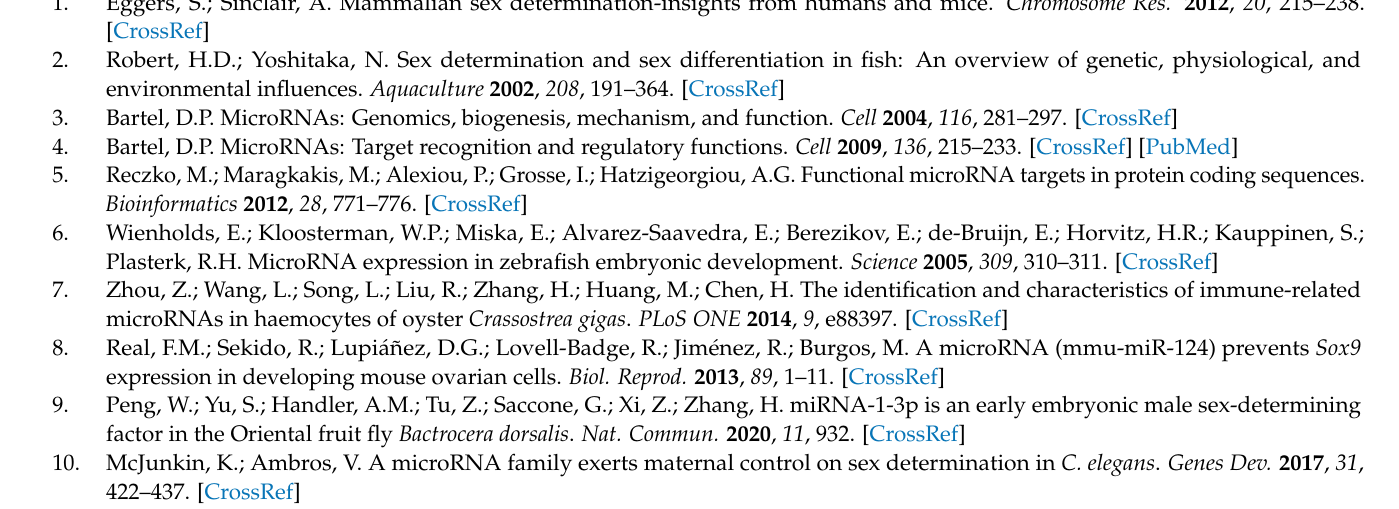
the miRNAs. Table S2: Specific primers for amplifying the target gene fragments. Table S3: The DEMs between testis and ovary. Table S4: Known miRNAs from ovary and testis libraries. Table S5: Novel miRNAs from ovary and testis libraries. Figure S1: Histological structure of gonad in juveniles with shell height of 5.0